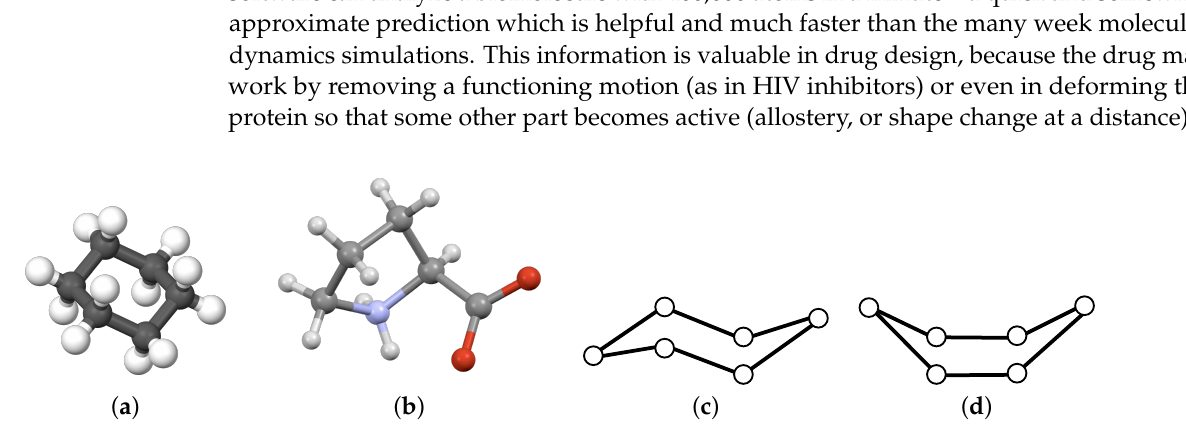
Figure 59. Two models of molecular rings: Cyclohexane ( a ) C 6 H 12 and Proline C 5 H 9 NO 2 ( b ). (Colour code: Carbon: grey; Hydrogen H: white; Nitrogen, N: blue; Oxygen, O: red.) Simplified rings of 6 carbons have two configurations: the ‘chair’ ( c ) which is rigid, and the ‘boat’ ( d ) which is flexible.